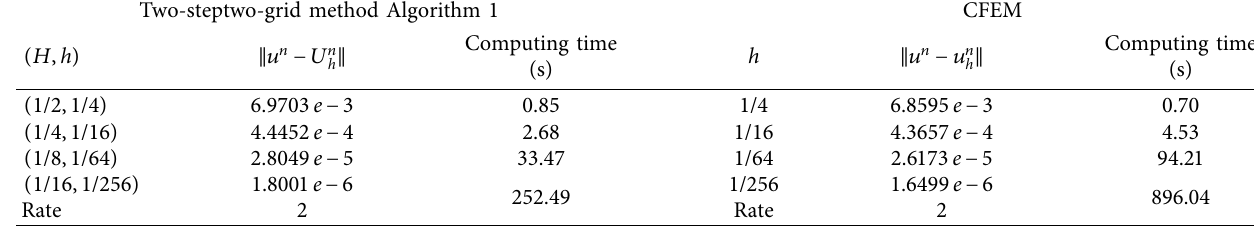
Table 2: Numerical results of two-steptwo-grid method Algorithm 1 and CFEM.